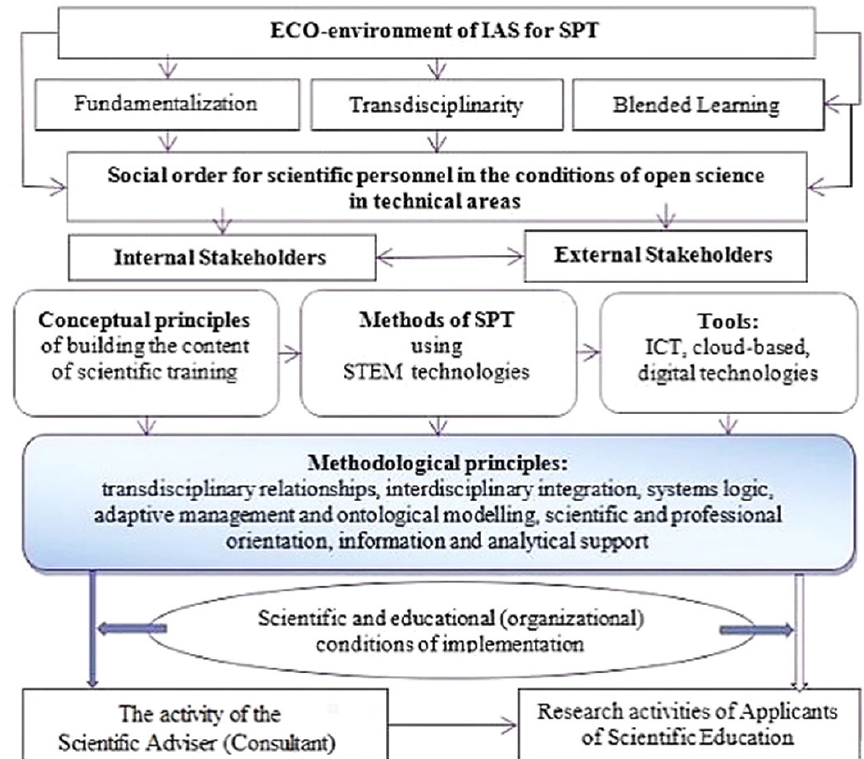
Fig. 1. Theoretical and methodological model of the ECO-Environment of IAS for SPT [1, 11,